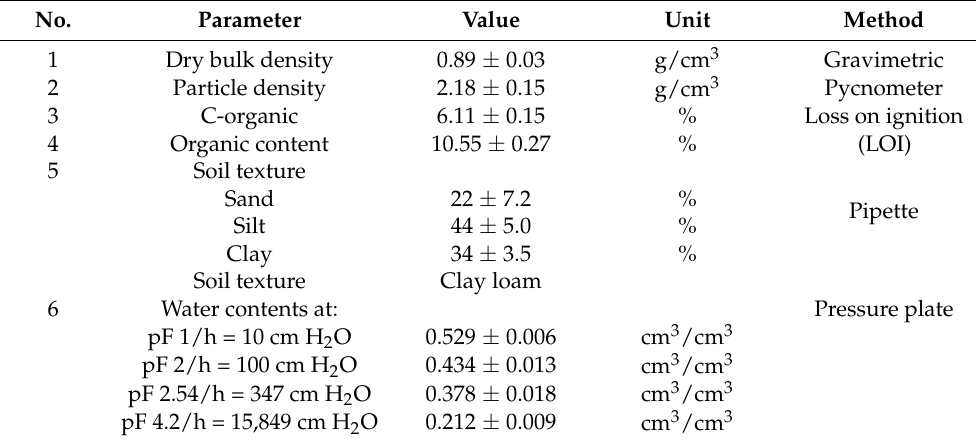
Table 1. Soil physical properties of the field location.